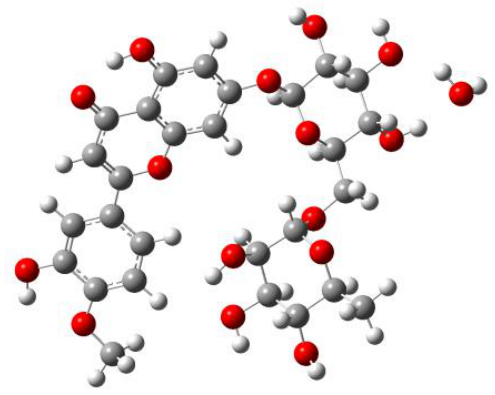
Figure 1. Structure of diosmin hydrate (DSNM).